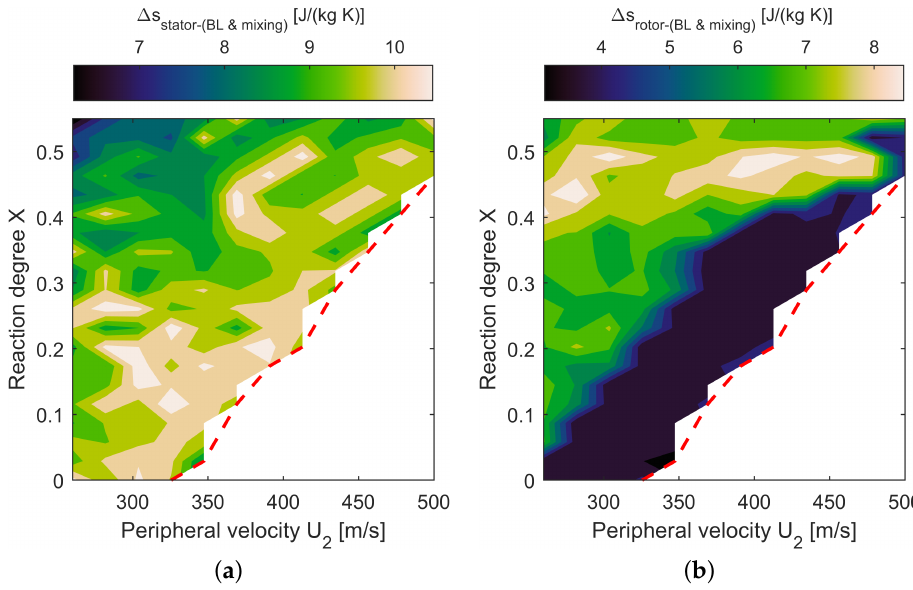
Figure 17. Entropy production [J/(kg K)] in the stator ( a ) and in the rotor ( b ) due to boundary layer and mixing for constant stator blade height and different reaction degree and peripheral velocity.